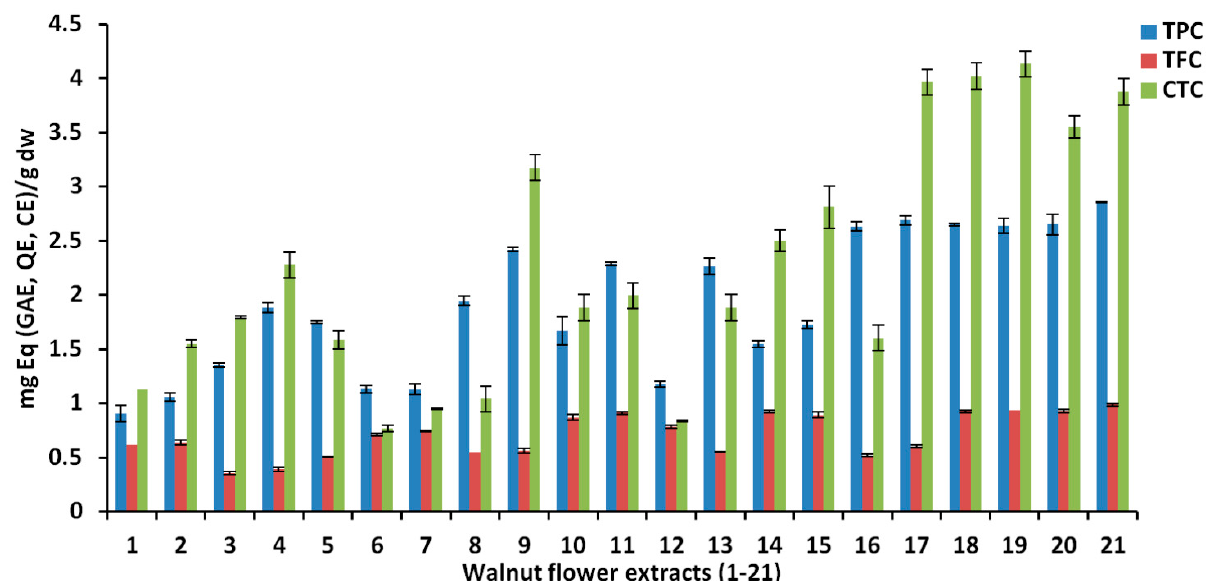
Figure 2. Total phenolic content (TPC), total flavonoid content (TFC) and condensed tannin content (CTC) of analyzed walnut flower extracts.